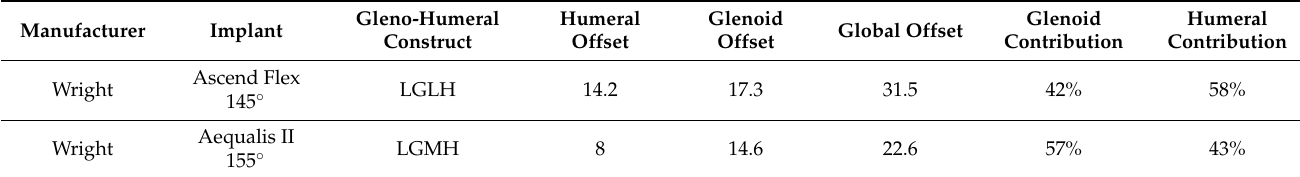
Table 1. Lateralization (Expressed in MM) of Different Components Used in Our